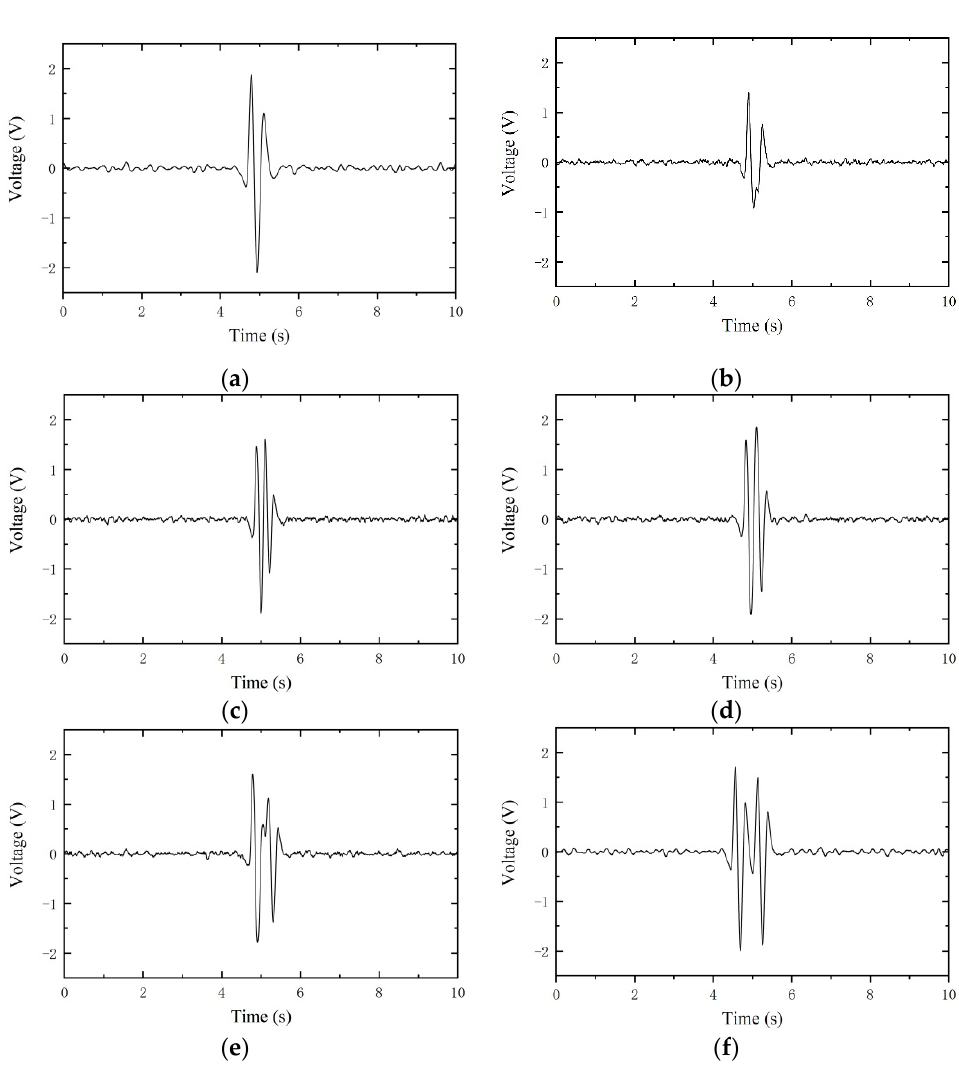
Figure 13. Induced voltage for two metal debris at different distances: ( a ) 15 mm; ( b ) 25 mm; ( c ) 40 mm; ( d ) 55 mm; ( e ) 70 mm; ( f ) 90 mm. ( c ) 40 mm; ( d ) 55 mm; ( e ) 70 mm; ( f ) 90 mm.